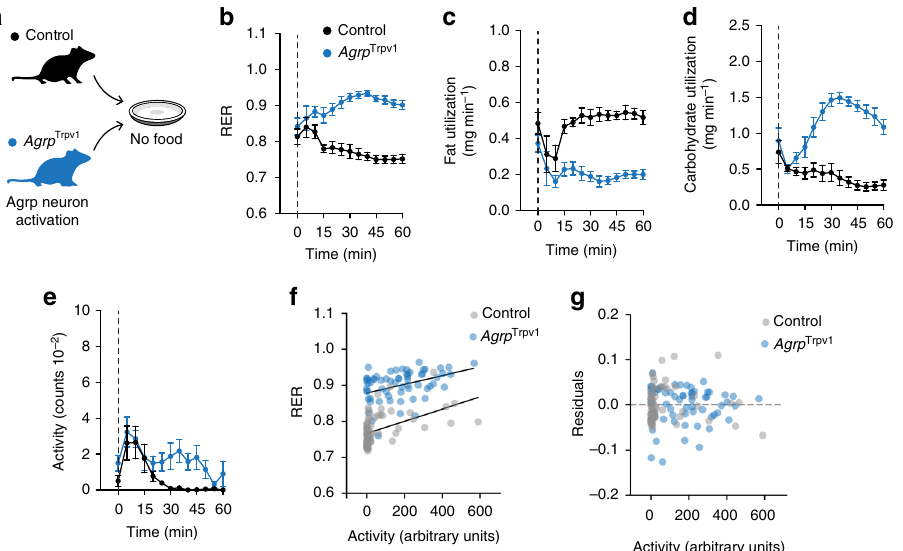
Fig. 3 Agrp neuron activation induces a shift in substrate utilization. a Control (black, n = 5) and Agrp Trpv1 (blue, n = 5) mice were tested in indirect calorimetry chambers upon injection of capsaicin without food provided. b Respiratory exchange ratio (RER) (interaction: F 12,96 = 8.96, P < 0.0001; time: F 12,96 = 1.31, P = 0.22; genotype: F 1,8 = 54.45, P < 0.0001). c Calculated fat utilization (interaction: F 12,96 = 3.52, P = 0.0002; time: F 12,96 = 3.23, P = 0.0006; genotype: F 1,8 = 55.31, P < 0.0001). d Calculated carbohydrate utilization (interaction: F 12,96 = 13.52, P < 0.0001; time: F 12,96 = 6.25, P <